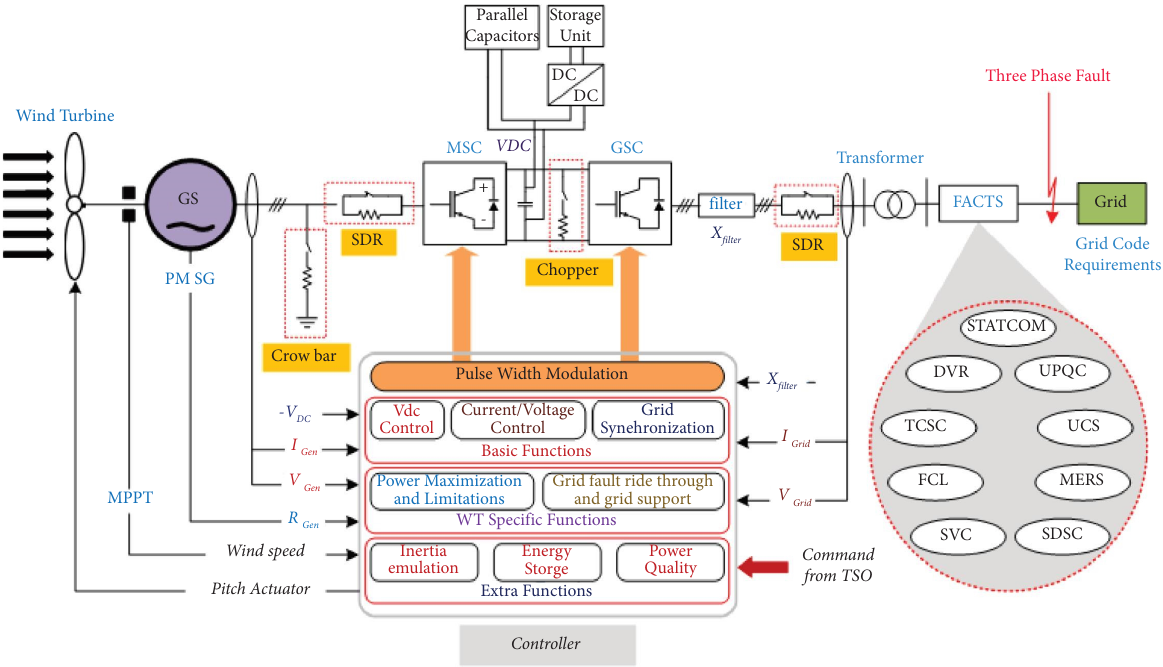
Figure 4: Te designed and implemented FRTC methods for PMSWG.